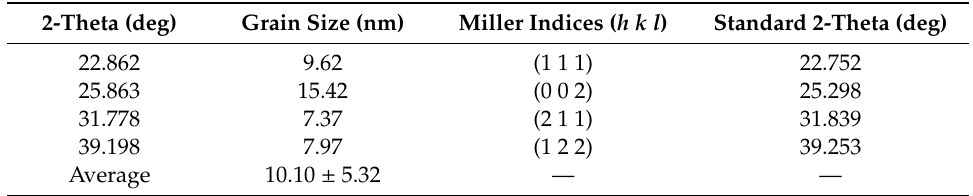
Figure 7. XRD patterns of HA coating on braid at different deposition time. Table 2. Grain size and Miller indices of main 2-Theta angles of HA crystals obtained after a 90 min deposition.